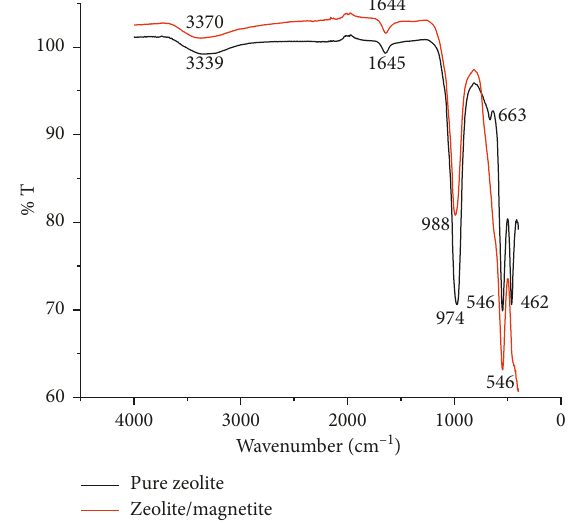
Figure 5: FT-IR of the pure zeolite and zeolite/magnetite